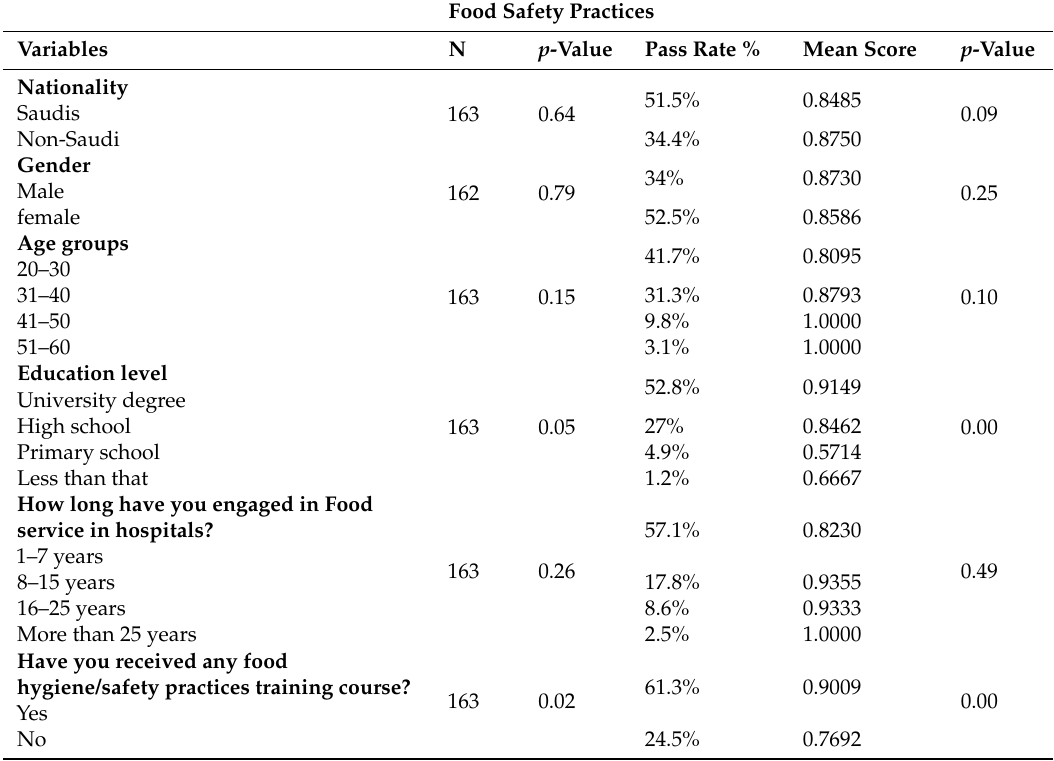
Table 8. Association between the demographic characteristics of participants and Food Safety